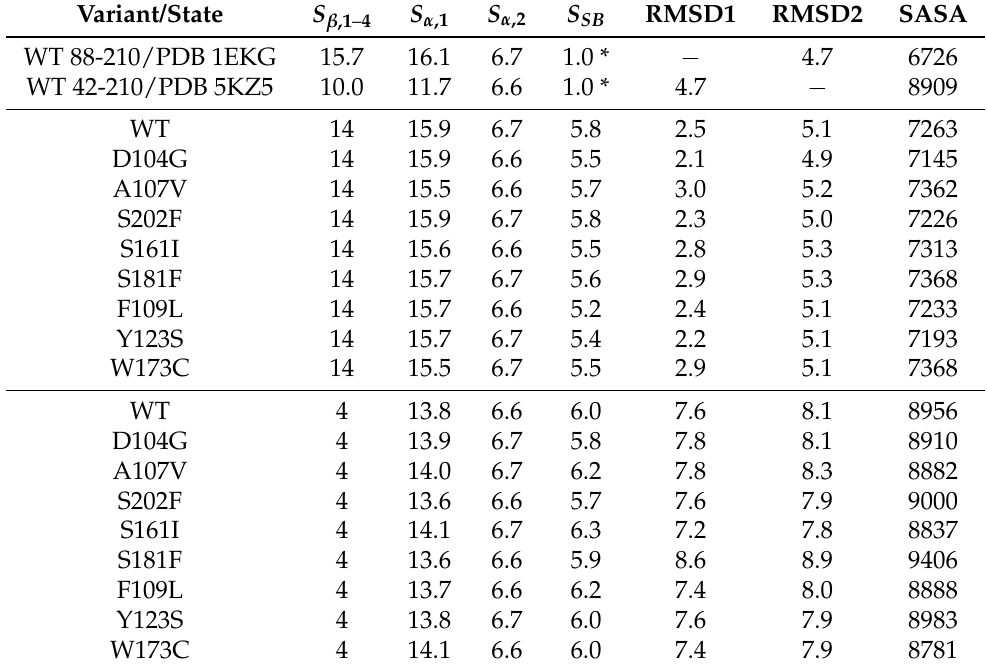
Table 2. Structural parameters S , RMSD1, RMSD2, and SASA obtained by imposing average values of CV to 4 and 14, see Section 5 for details. (*) The low S SB is due to the formation of inter-molecular elec- trostatic interactions responsible of the crystal packing. SASA (Å 2 ) and RMSD (Å) for PDB structures are computed using residues 90-210. RMSD is computed using non-hydrogen backbone